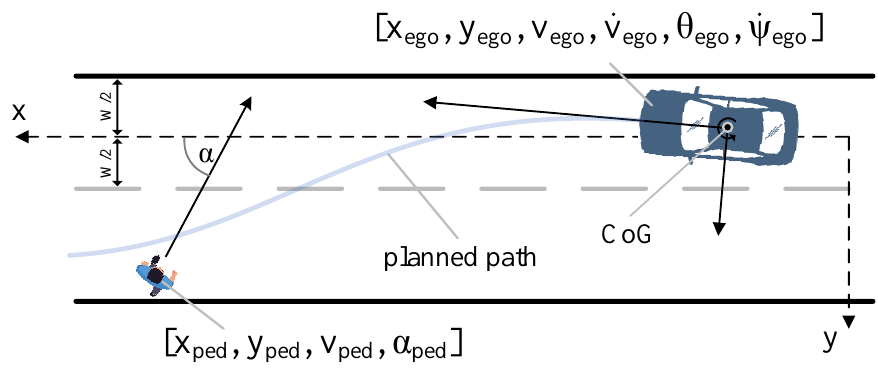
Figure 3. State representation of the training environment.